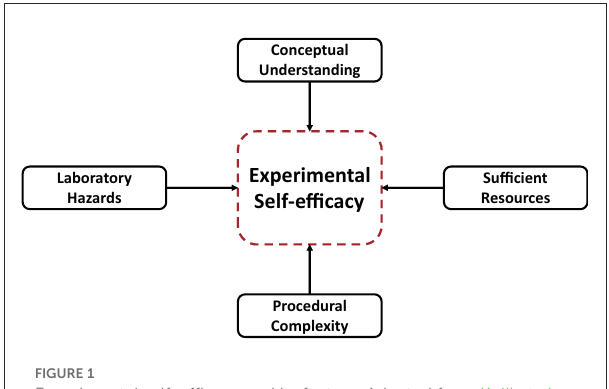
FIGURE1 Experimental self-efficacy and its factors. Adapted from Kolil et al. (2020).